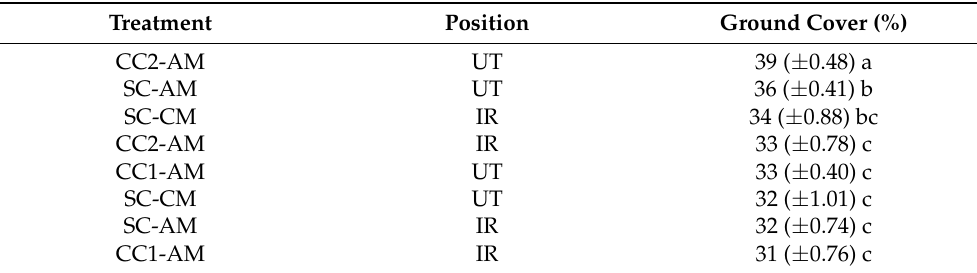
Table 2. Effect of the interaction between treatments (CC1-AM, CC2-AM, SC-AM, SC-CM) and positions (IR and UT) on ground cover percentage. CC1-AM: cover crop 1 autonomously mowed; CC2-AM: cover crop 2 autonomously mowed; SC-CM: spontaneous cover autonomously mowed, SC-AM: spontaneous cover conventionally